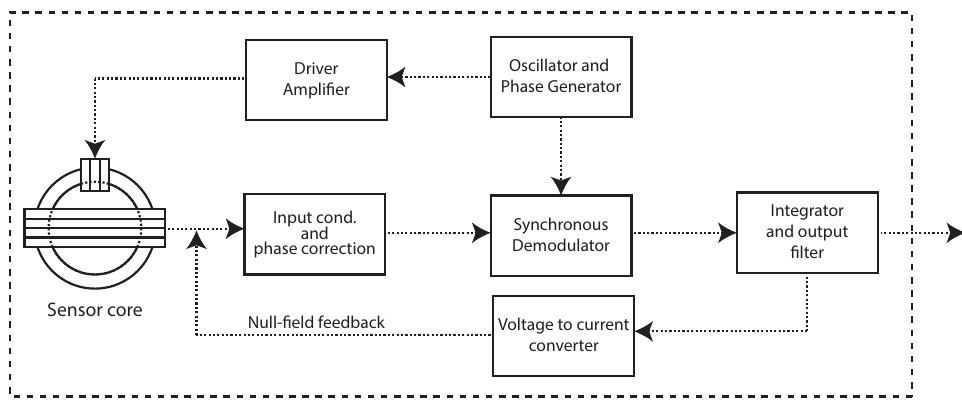
Figure 2. Block diagram of the sensor conditioning electronic